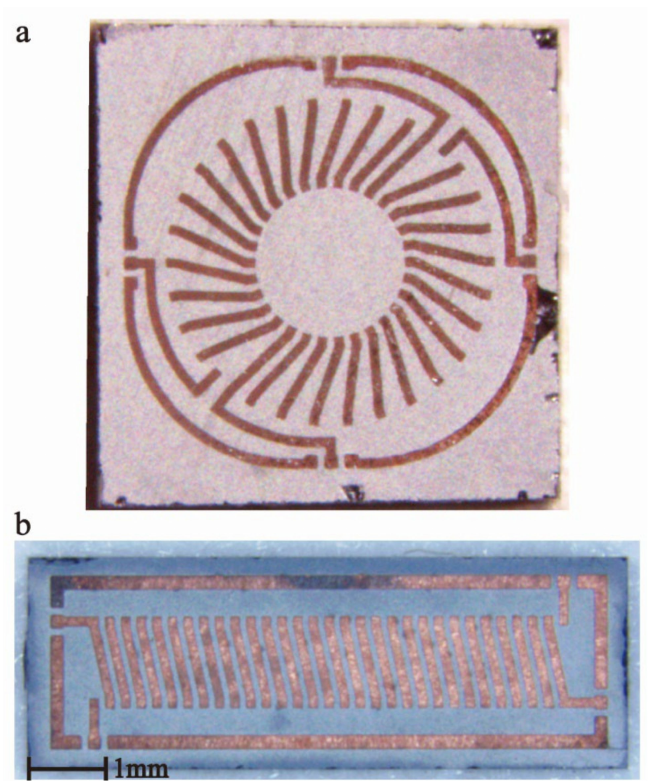
Figure 8. ( a ) Toroidal and ( b ) solenoidal structure transformers.